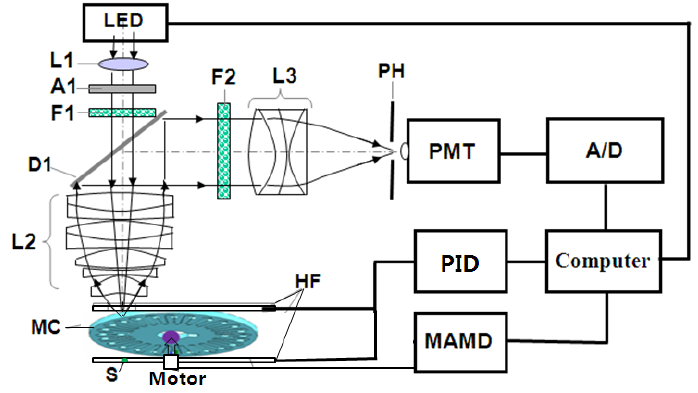
Fig. 2. Structure of the portable confocal optical °uorescence